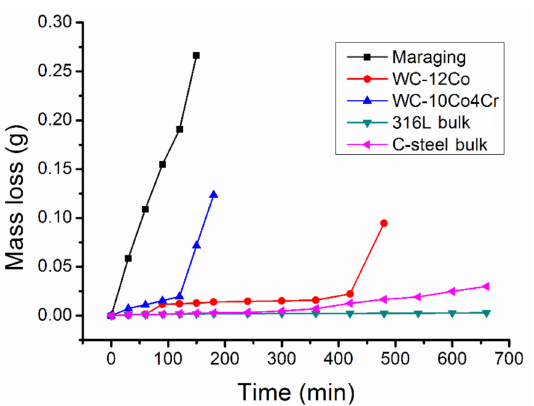
Figure 9. Accumulated mass loss from jet erosion